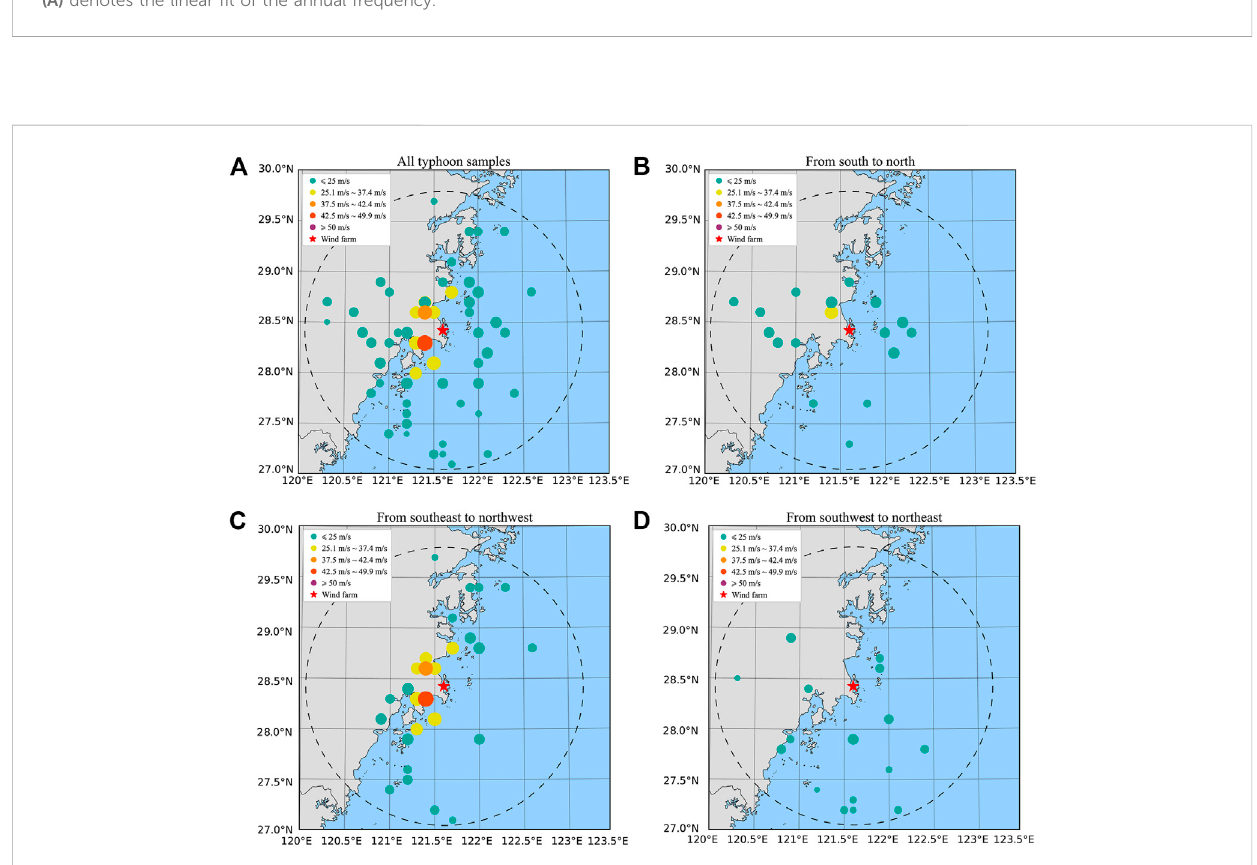
(Figure 3C, Figure 3B), with some tropical cyclones traveling from southeast to northwest reaching super typhoon intensity. The intensity of most of the tropical cyclones moving from southwest to northeast diminished to tropical depression level by the time they passed the wind farm area (Figure 3D).